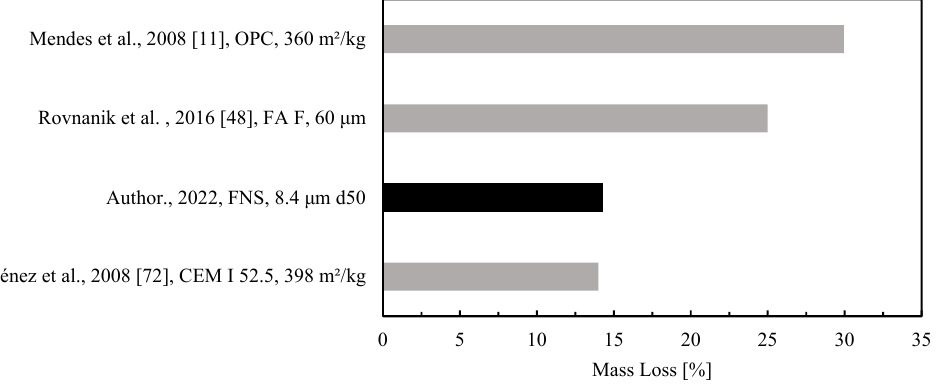
Figure 4. Mass loss of low-calcium alkali-activated and cement-based pastes after exposure to a thermal load between 800 and 1000 °C.